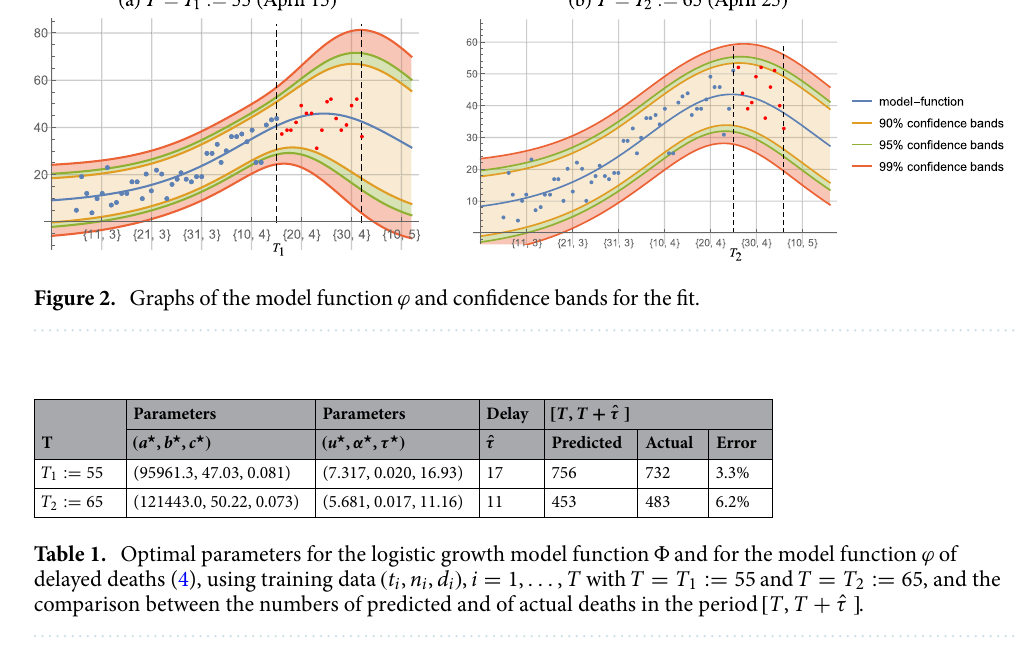
δ 1 17 . Figure 3a shows the graph of the model function ψ (blue curve). ˆ = Red dots represent the actual numbers of hospitalized during the 17-day period following April 10. Visualized